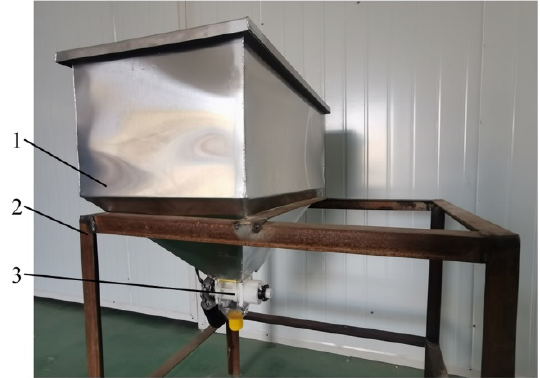
Figure 13. Fertilizer discharge test bench: 1, fertilizer tank; 2, mounting frame; 3, electric fertilizer discharger.